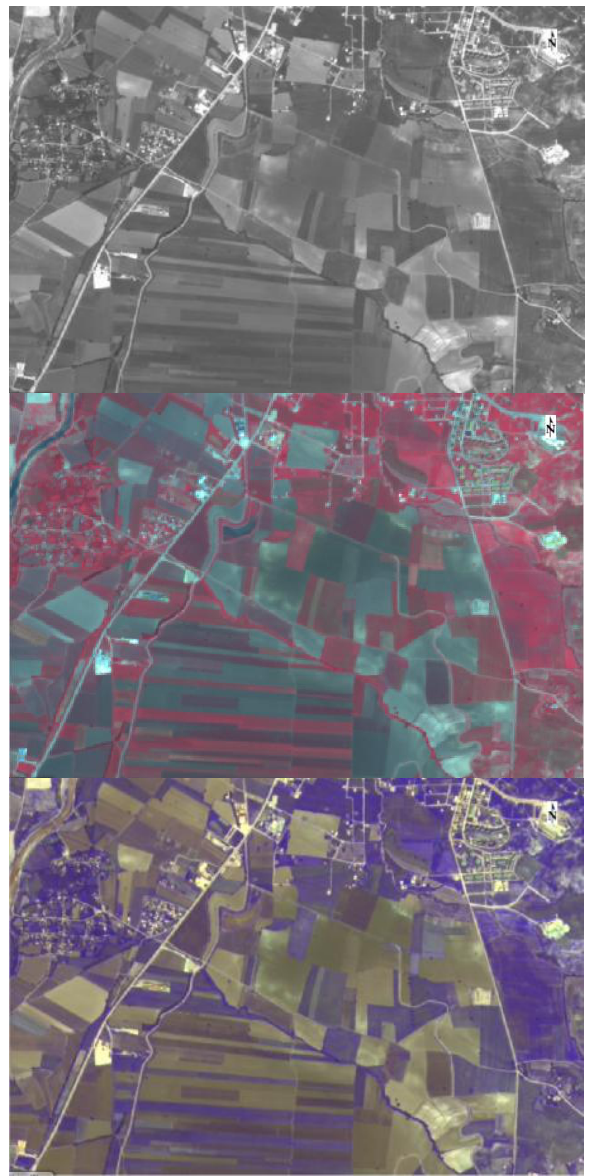
Figure 2. Pancromatic image, multispectral image and pan sharpened image.